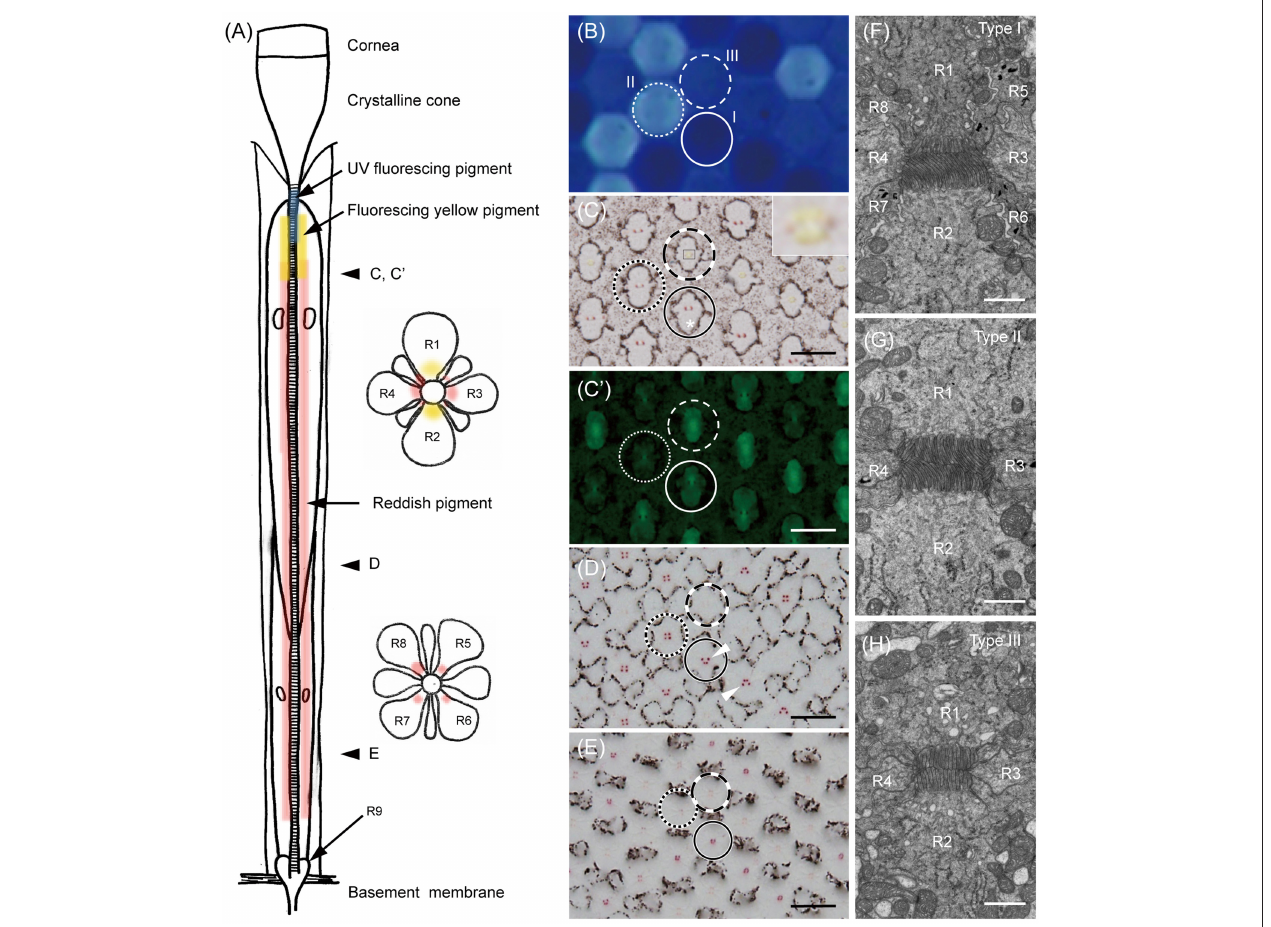
FIGURE 1 | The ommatidia of Graphium sarpedon . (A) Schematic drawing of an ommatidium in longitudinal (left) and transverse (right) views. R1–9; photoreceptor cells. (B) Fluorescence micrograph of intact eye under UV epi-illumination showing three types of ommatidia emitting no (type I, solid circle), strong (type II, dotted circle), and weak (type III, dashed circle) fluorescence. (C) Light micrograph of a transverse section, about 220 µ m from the corneal surface, of the eye region shown in B . Asterisk shows the position of the cell body of R2. Type III ommatidia have yellowish pigment around the rhabdom in R1–2 (the region marked with a rectangle is enlarged in the inset), which fluoresces under blue-violet excitation (C’) , in addition to reddish perirhabdomal pigment in R3–4. (D–E) The same specimen sectioned at about 300 µ m (D) and 400 µ m (E) depths, showing the pigmentation in the proximal tier. Type III ommatidia have pale-red pigments around the rhabdom in R5–8, while other ommatidia have red pigments. (F–H) Electron micrographs of rhabdoms of type I (F) , II (G), and III (H) ommatidia in the distal tier. Scale bar 20 µ m in (C–E) , 1 µ m in (F–H)